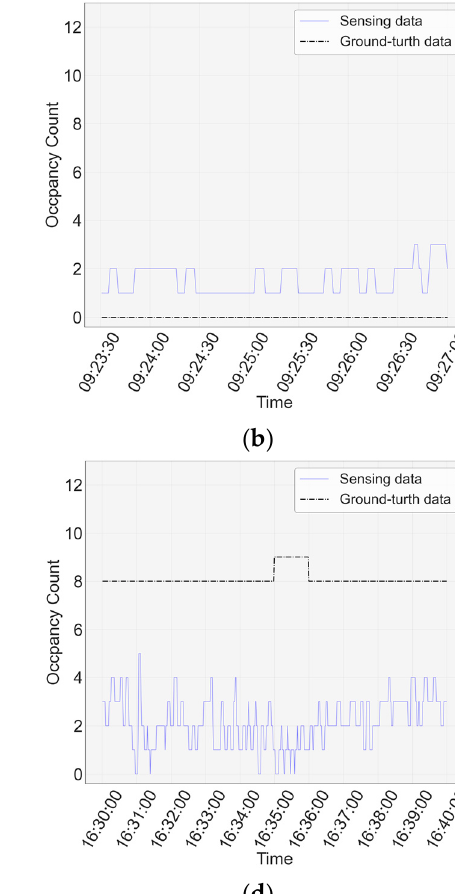
Figure 8. Analysis of occupancy count error distribution between sensing and ground-truth data: